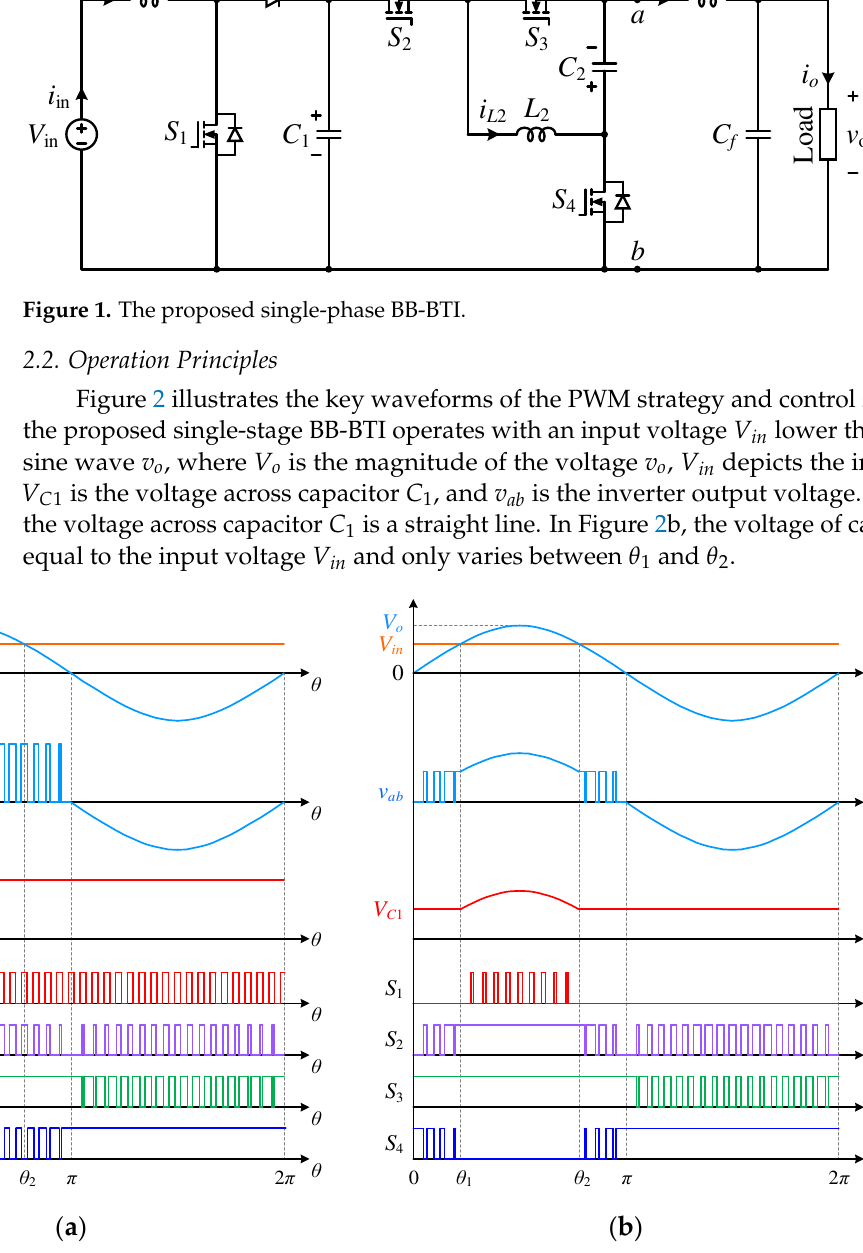
Figure 2. PWM control method for ( a ) conventional two-stage BB-BTI and ( b ) the proposed single- stage BB-BTI.